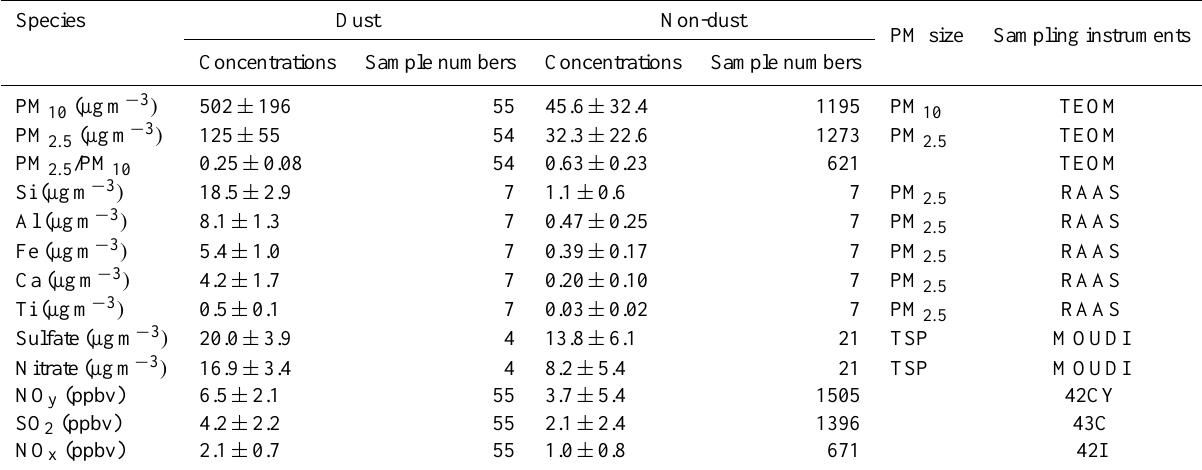
Table 1. Comparison of chemical species in non-dust and dust storm periods during the Mt. Heng study. Species Dust